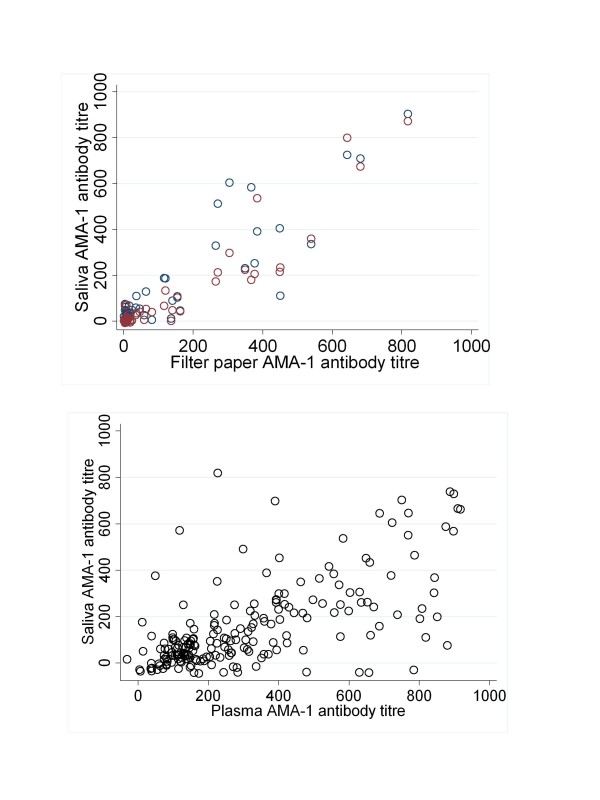
Scatterplots showing relationship between paired antibody titres from plasma and saliva to P. falciparum merozoite surface antigen AMA-1 in a)Tanzania and b) The Gambia. In plot a) open red circles represent measures by OraSure and blue circles by OraCol.